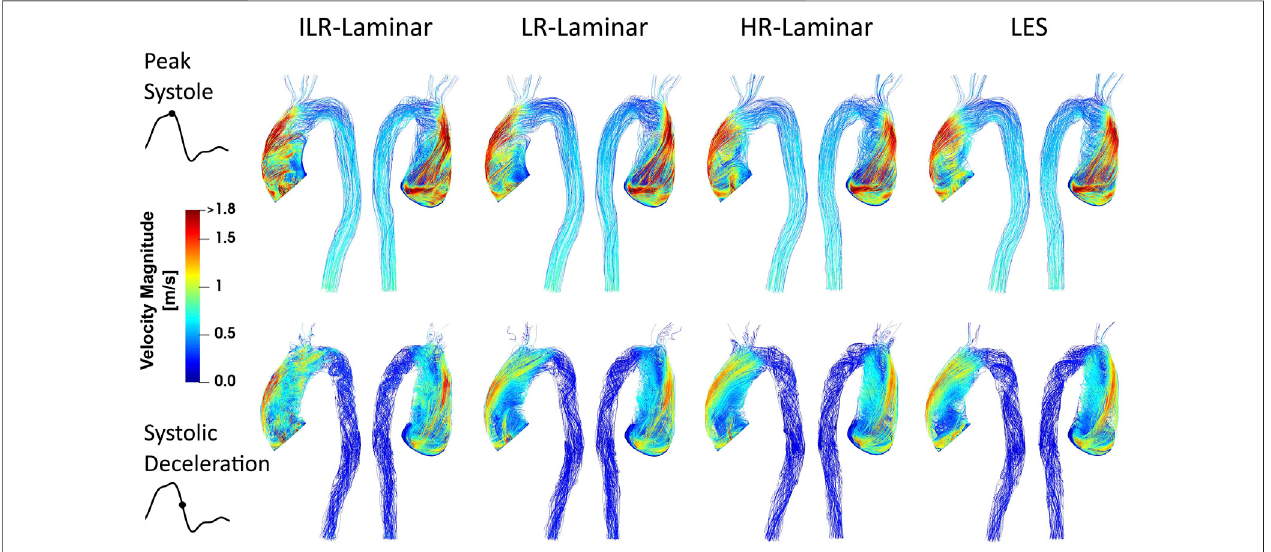
FIGURE 2 | Velocity magnitude streamlines at peak systole (top row) and systolic deceleration (bottom row) for ILR-Laminar, LR-Laminar, HR-Laminar and LES simulations.